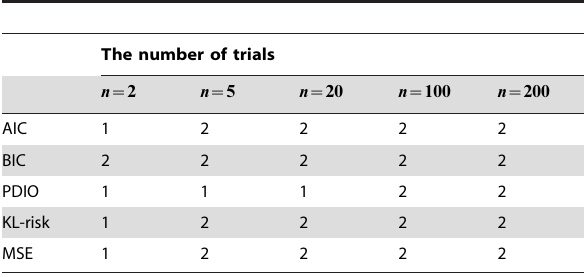
Table 5. Model orders selected using different information criteria for model without triple-wise spike interaction.